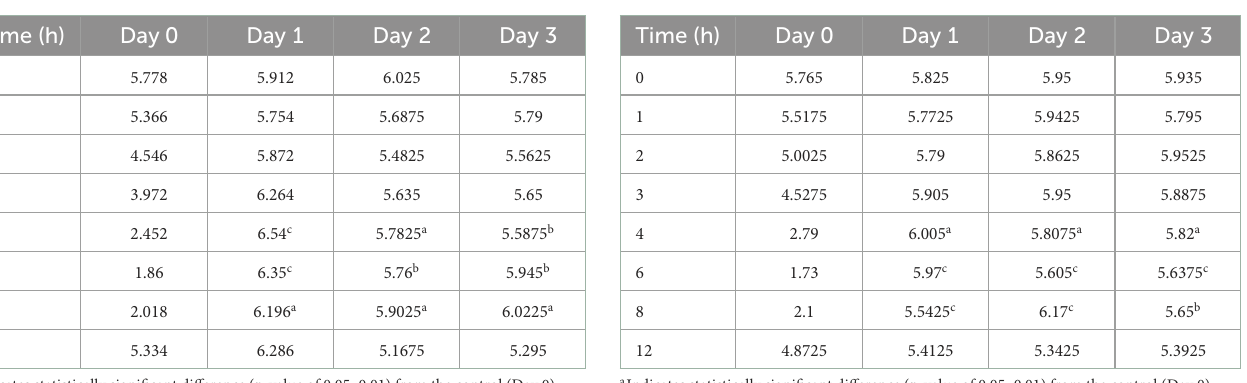
TABLE 6 Comparison of average hourly abomasal pH after subcutaneous administration of